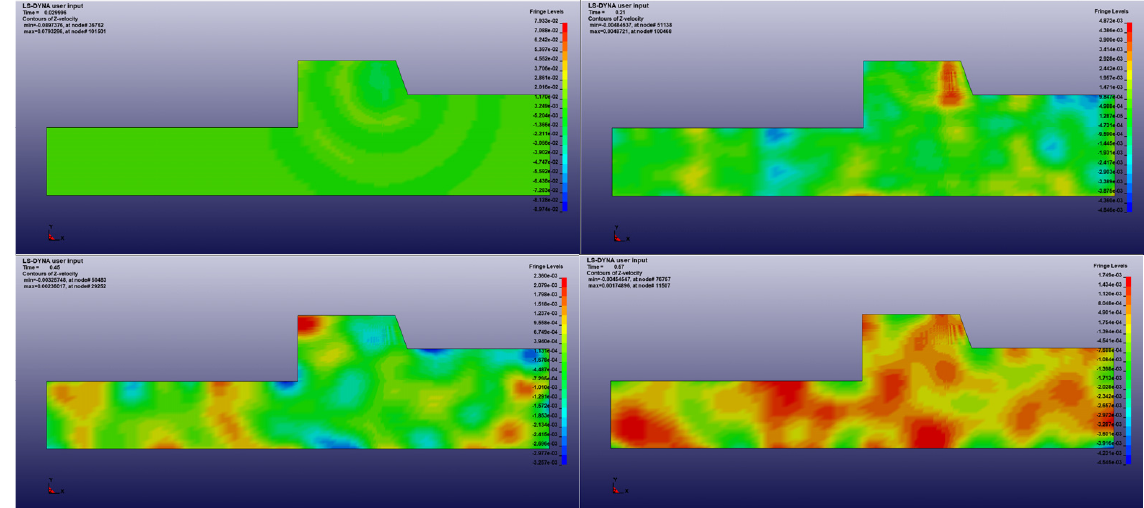
Figure 11. Tangential velocity clouds at different time points for an elevation of 20 m.